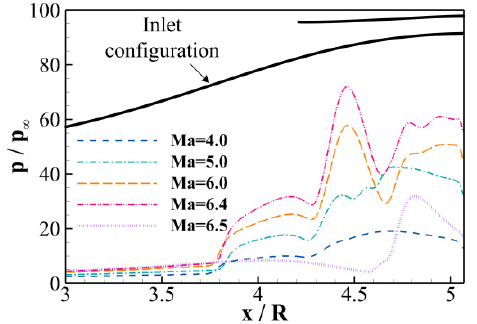
Figure 12. Wall pressure distributions during the starting process of the inlet with δ = 0°.